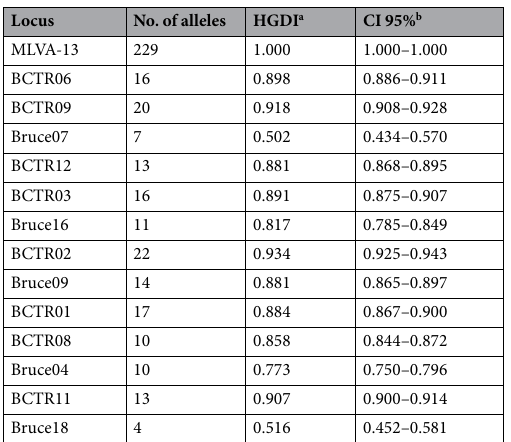
Table 3. Number of alleles and discriminatory index generated by the MLVA-13Bc method and by individual VNTR locus on 229 B . canis isolates. a Hunter-Gaston Discriminatory Index (HGDI). b 95% confidence interval of HGDI for each locus.